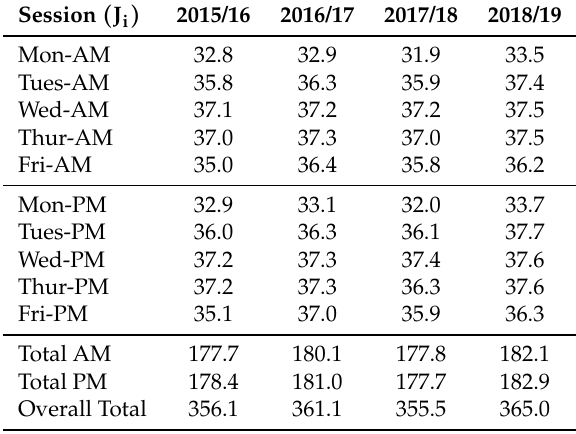
Table A3. Actual average attendance for each session for 2015/16, 2016/17, 2017/18, and